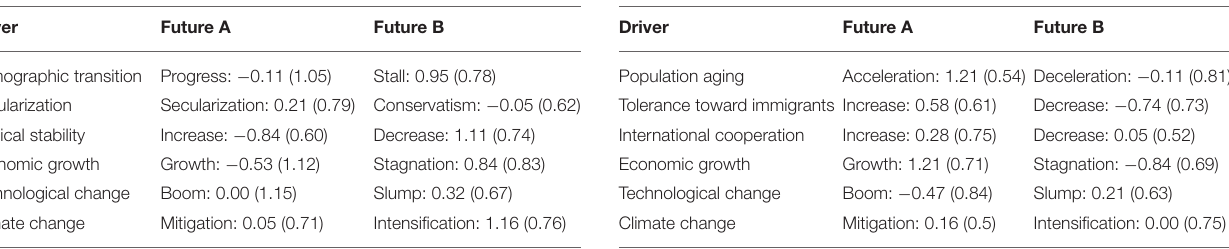
deviations between parentheses).